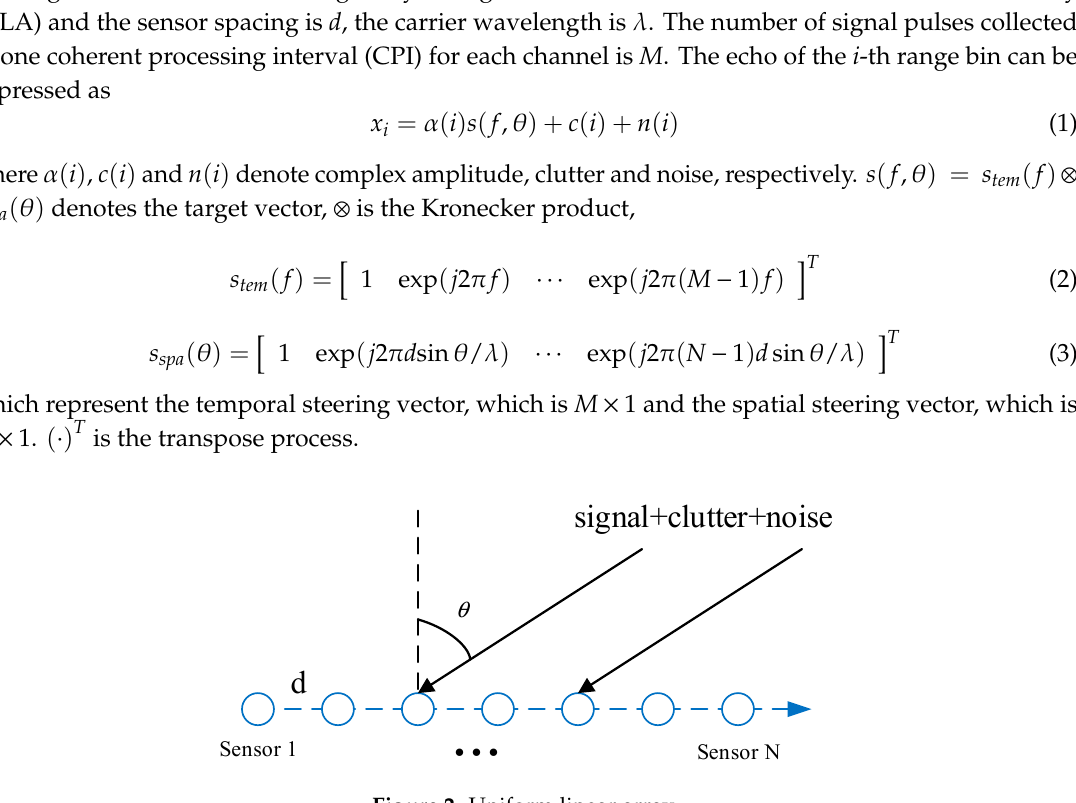
Figure 2. Uniform linear array.